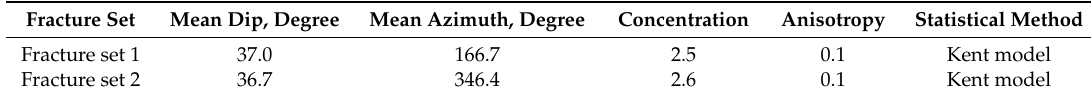
Table 5. Statistical parameters of different fracture sets.